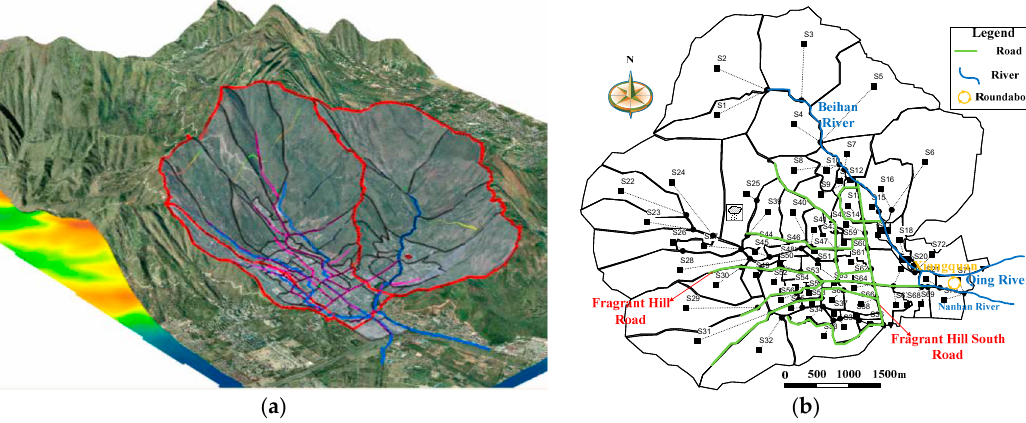
Figure 3. Drainage system ( a ); and sub-catchments ( b ) of study area. In this drainage system map ( a ), rea lines are mountain ridges, blue lines are rivers, black lines are mountain gullies and pink lines are roads.